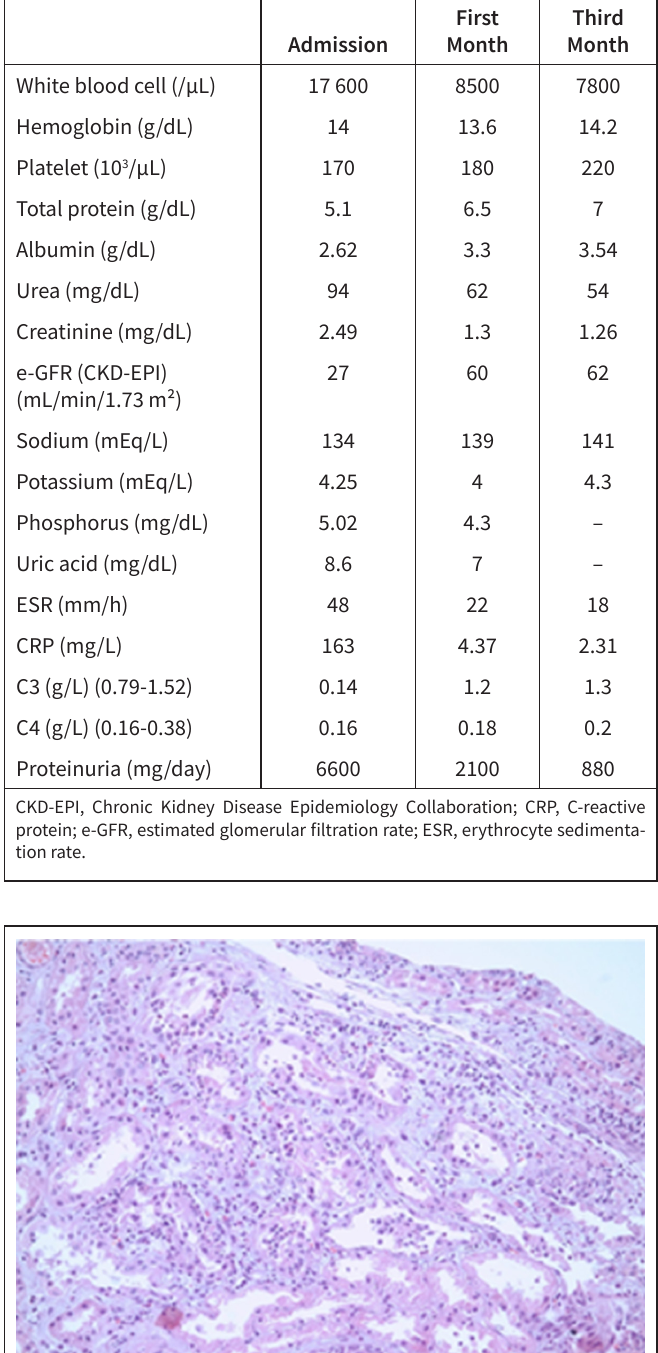
Table 1. Laboratory Findings on Admission and Follow-Up of the Patient